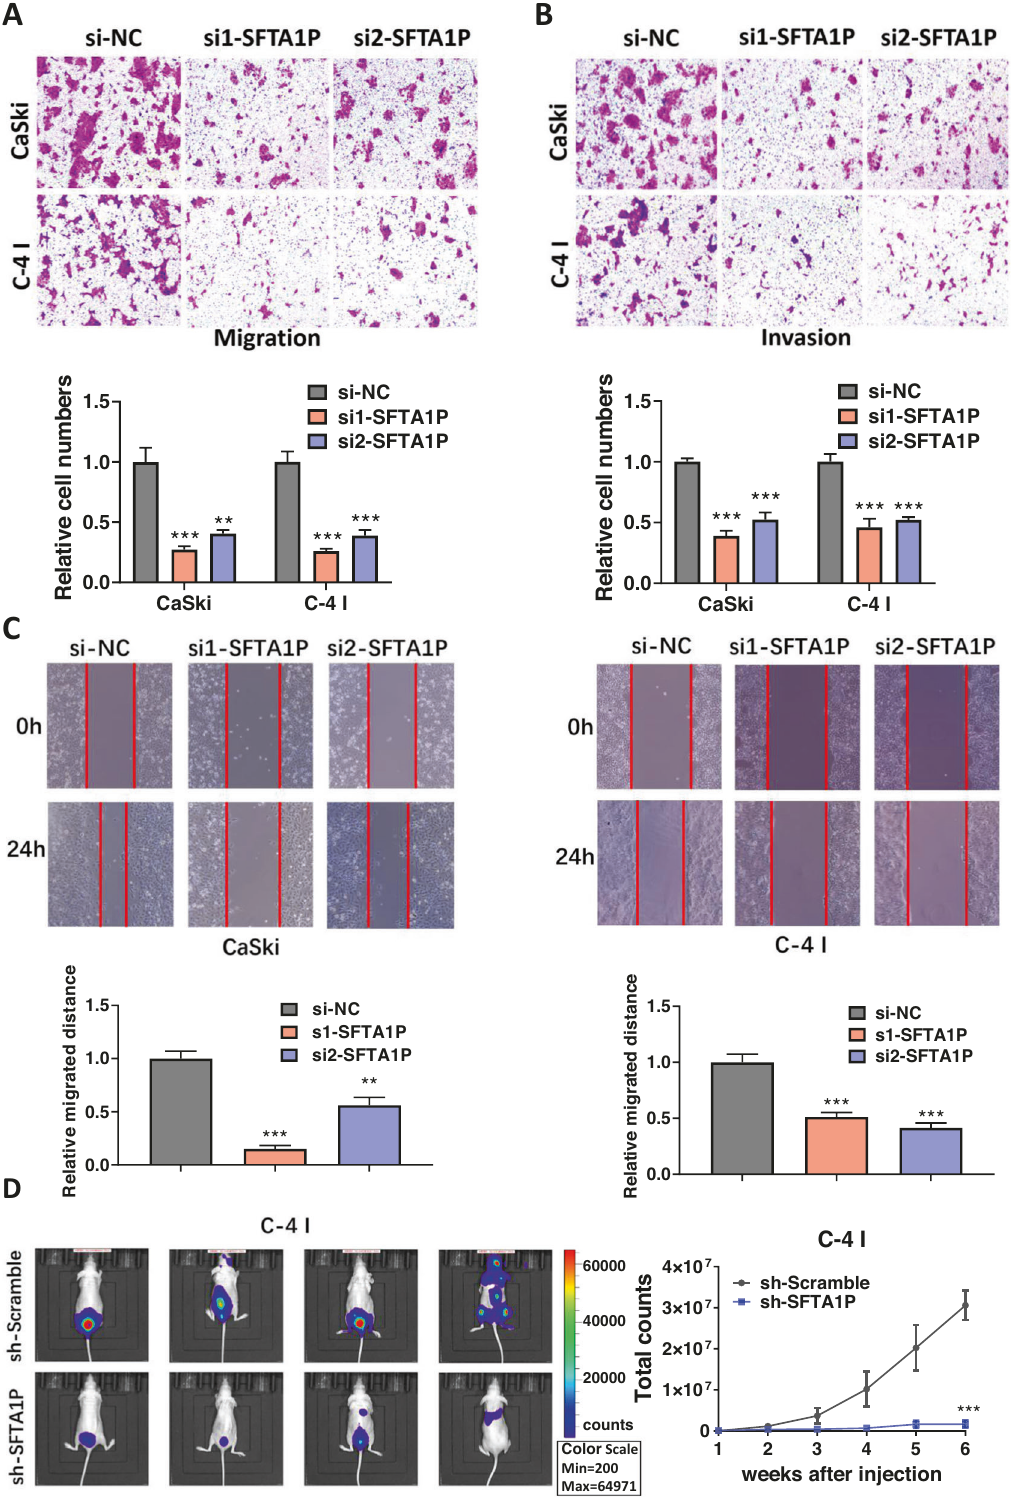
Fig. 3 SFTA1P promotes cervical cancer cell metastasis in vitro and in vivo. A , B Migration and invasion ability of CaSki and C-4 I cells transfected with SFTA1P siRNA or NC. C Wound healing assays of CaSki and C-4 I cells transfected with SFTA1P siRNA or NC. D SFTA1P promotes cervical cancer cell metastasis in vivo. Nude mice were injected intravenously with sh-scramble or sh-SFTA1P cells via the tail vein. Secondary metastatic sites were observed mainly in the pelvic cavity, followed by the lung and brain. The mice were imaged weekly for 6 weeks. Data are shown as mean ± SEM. * P < 0.05; ** P < 0.01; *** P < 0.001.